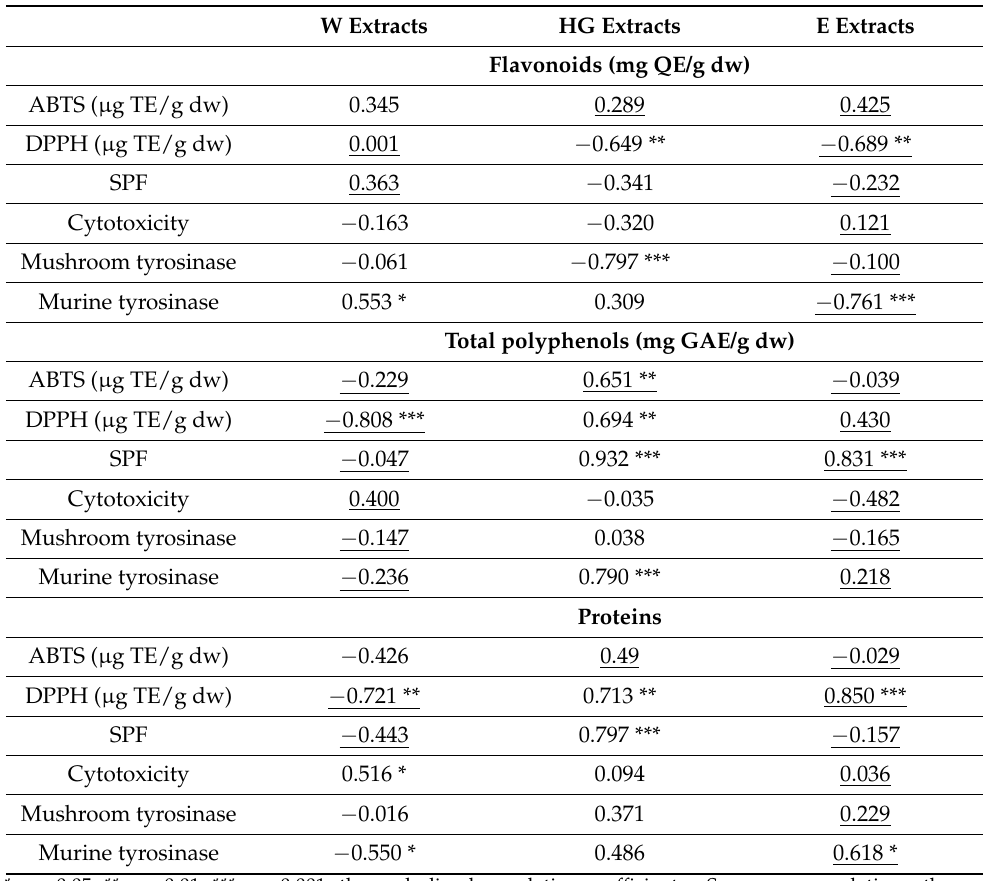
Table 9. The results of the correlation analysis between the activity of the Cucurbita spp. peel extracts and the content of phenolic compounds, flavonoids and